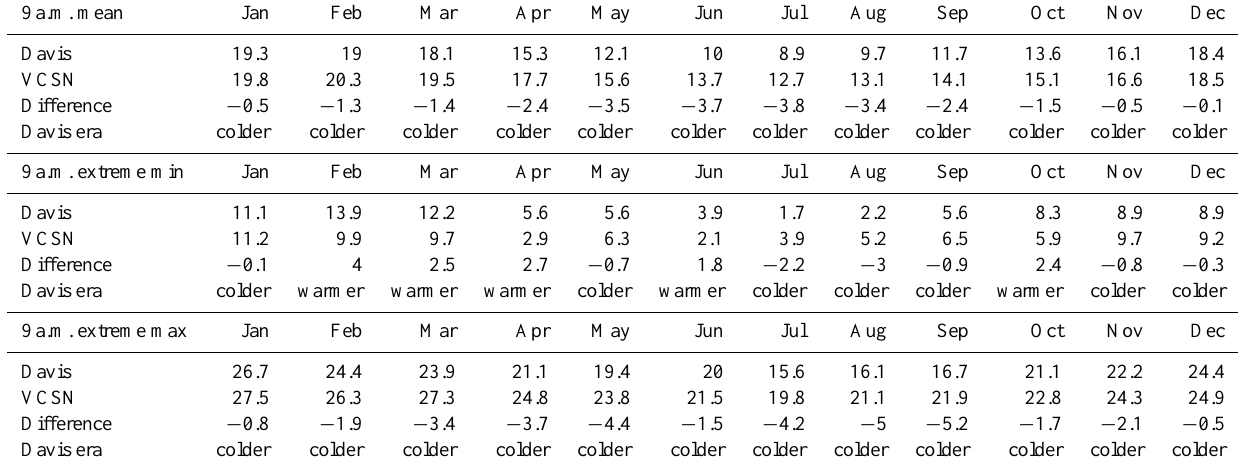
Table 2. VCSN-equivalent temperatures from the Davis diary for 9a.m. mean, 9a.m. extreme minimum and 9a.m. extreme maximum values with reference to VCSN 9a.m. temperature data for